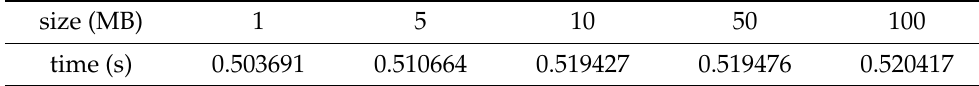
Table 3. The time needed for restoring the external